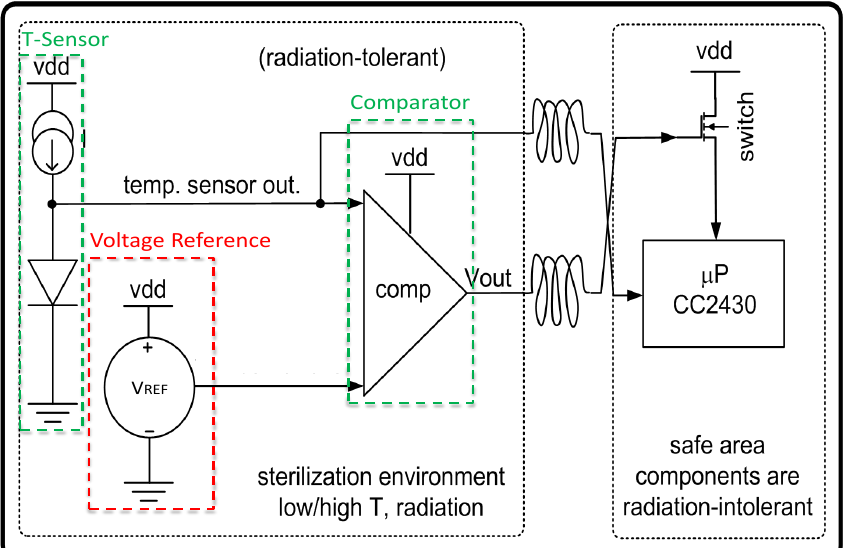
Figure 1. Biomedical microsystem adapted from [1].